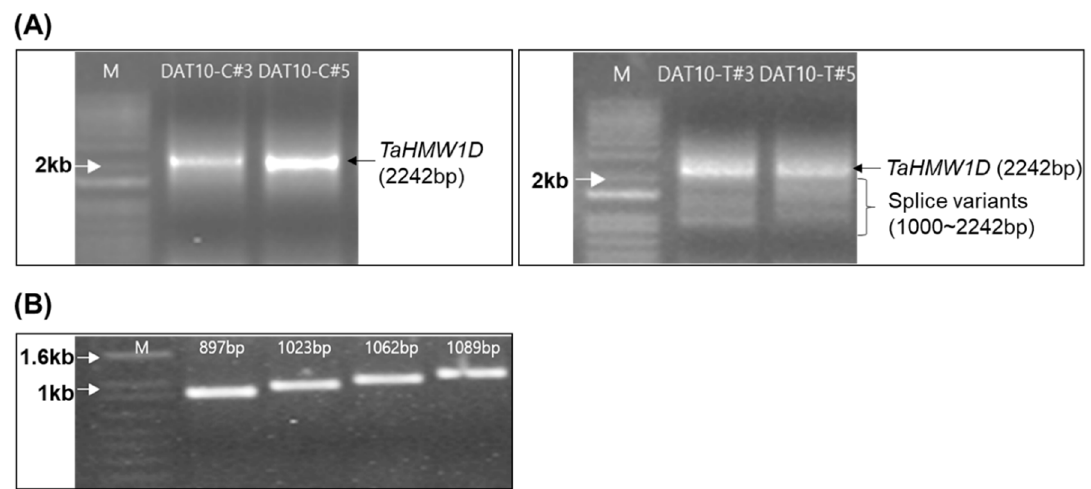
Figure 5. Identification of transcript variants. ( A ) Agarose gel (1%) showing the 2242-bp TaHMW1D gene product from control plants (left). The PCR products of high-temperature stress-treated wheat show smaller-sized (1000–2242 bp) transcript variants (right). ( B ) Sizes of the TaHMW1D transcript variants. Table 2. The most abundant repeat sequences in TaHMW1D (sequences that experience specific deletion sites after high- temperature stress are underlined).